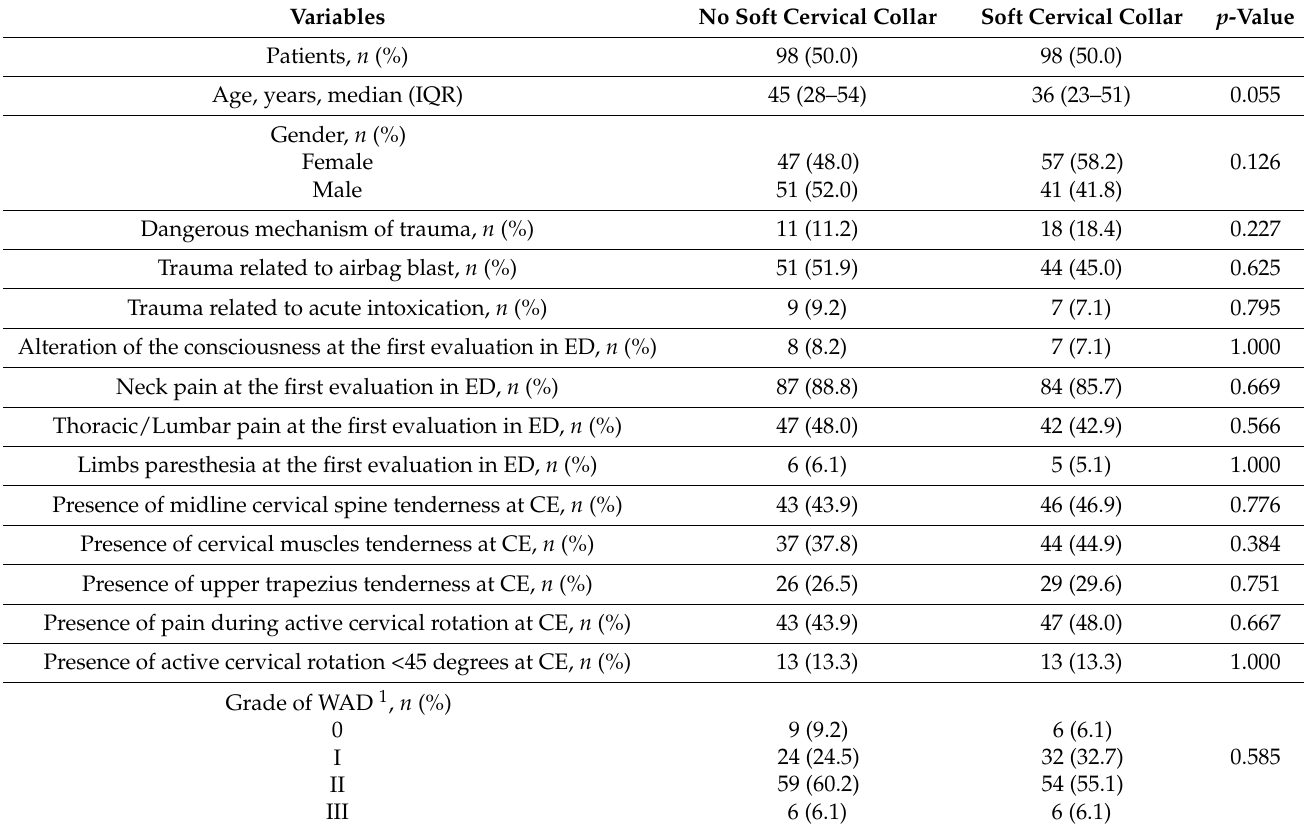
Table 4. Propensity score matching for collar application.